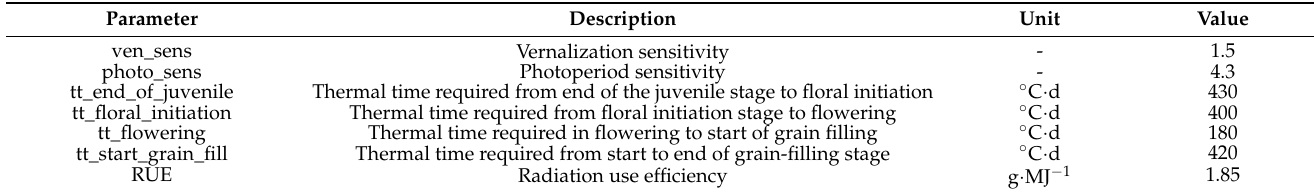
Table 2. Calibrated cultivar parameters of local oat variety “Qingyin 2” on the Tibetan Plateau. Parameter Description Unit Value ven_sens Vernalization sensitivity - 1.5 photo_sens Photoperiod sensitivity - 4.3